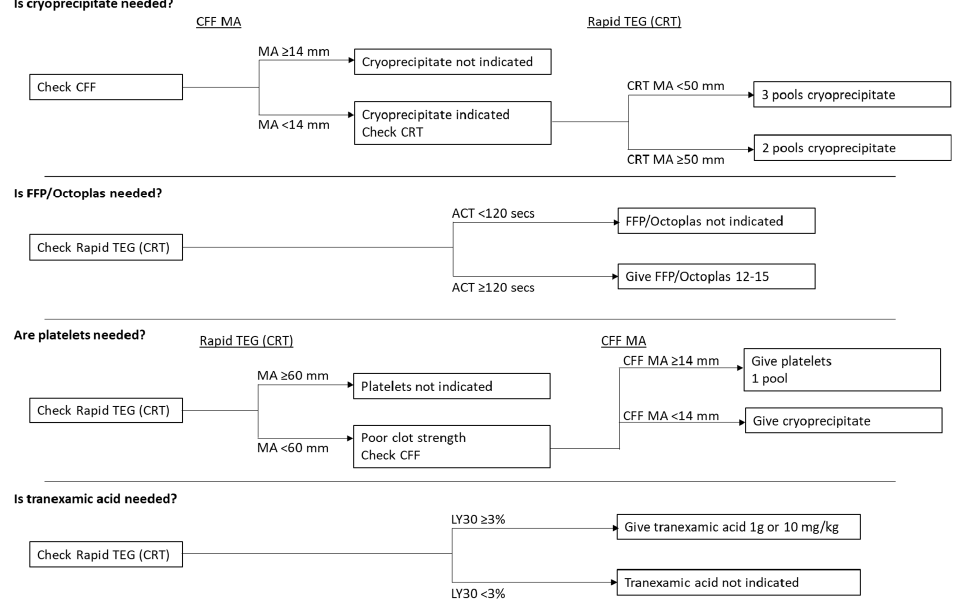
Figure 2. Major Trauma TEG 6s protocol. ACT, TEG activated clotting time; CFF, citrated functional fibrinogen; CRT, citrated RapidTEG; FFP, fresh frozen plasma; LY30, lysis 30; MA, maximal amplitude.